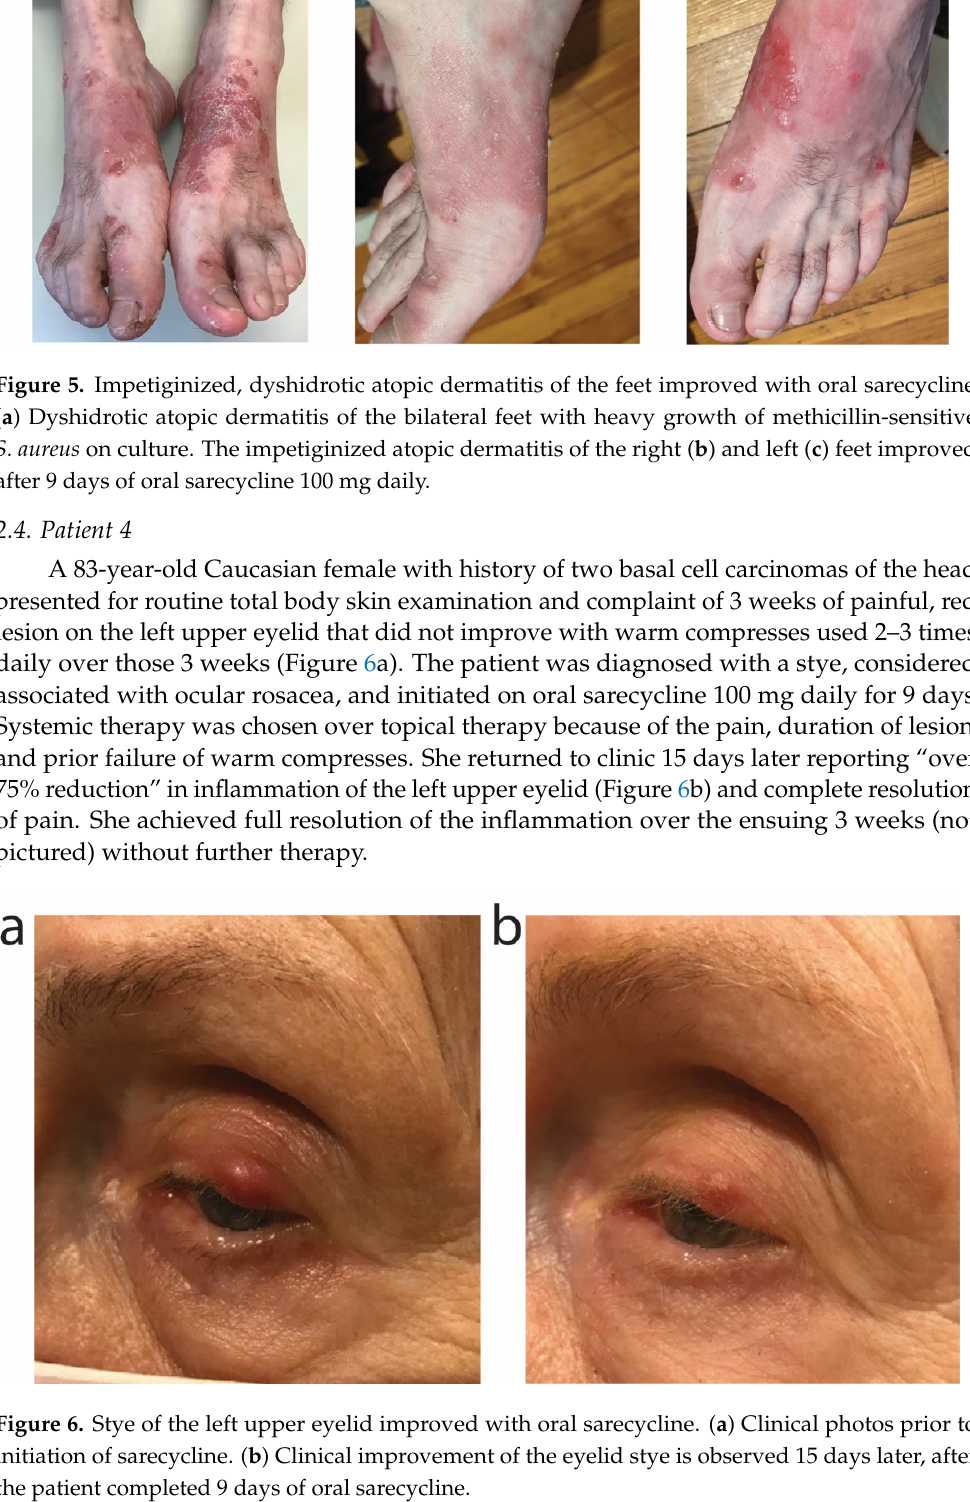
7 of 14 Figure 4 . Impetiginized atopic dermatitis improved with oral sarecycline. Impetiginized atopic der- matitis of the bilateral upper extremities moreso than the chest and abdomen ( a ) improved after sarecycline 150 mg daily for 9 days ( b ). 2.3. Patient 3 A 36-year-old Caucasian male with history of atopic dermatitis associated with marked dyshidrosis of the feet moreso than hands and IgE elevation to 465 kU/L (upper limit of normal 114 kU/L) presented with pruritic, erythematous, crusted plaques on the feet despite ongoing therapy with dupilumab 300 mg every 2 weeks (Figure 5a). A super- ficial aerobic culture from the left dorsal foot identified heavy growth of methicillin-sen-